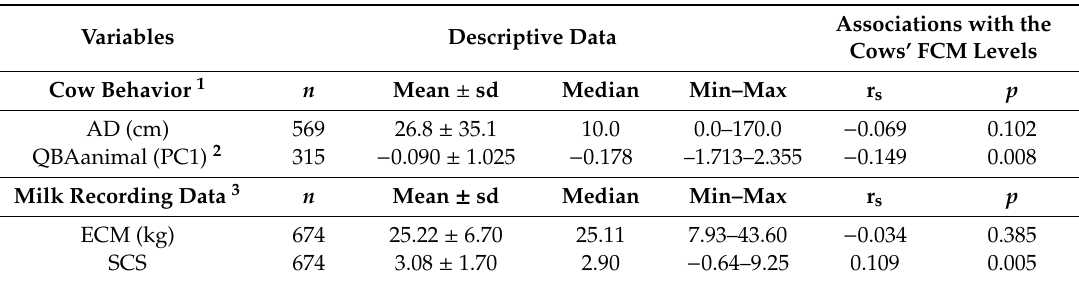
Table 4. Descriptive data of cows’ behaviors towards humans, milk yield, and udder health at animal level; and univariable associations with the cows’ FCM levels (ng / g), analyzed by means of Spearman rank correlations (r s